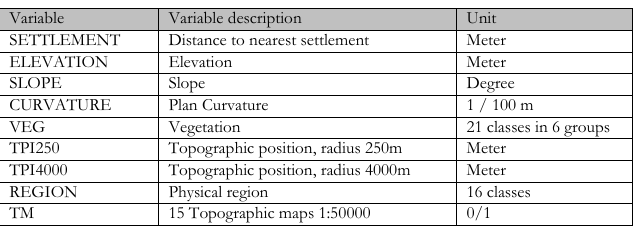
Table 1: Explanatory variables tested for their relevance for the occurrence of